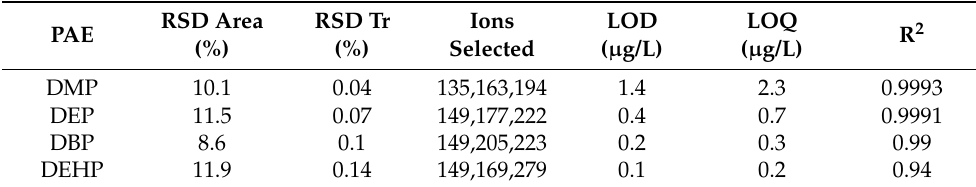
Table 2. RSD from the absolute peak area and from the retention time ( n = 5). Ions selected, LOD, LOQ and R 2 for the linear range studied.